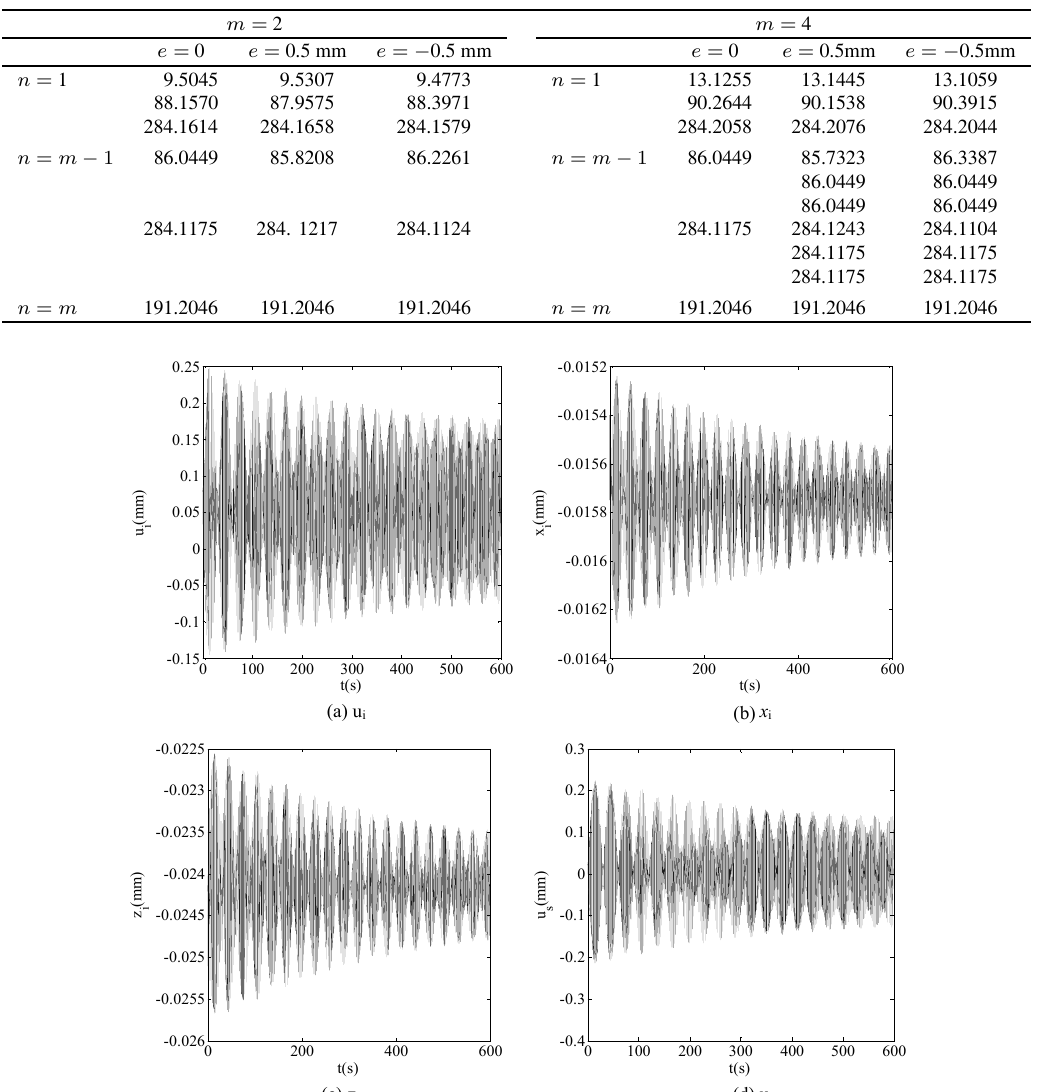
Fig. 4. The forced responses of the drive system to the dynamic eccentric center ( ω = 81